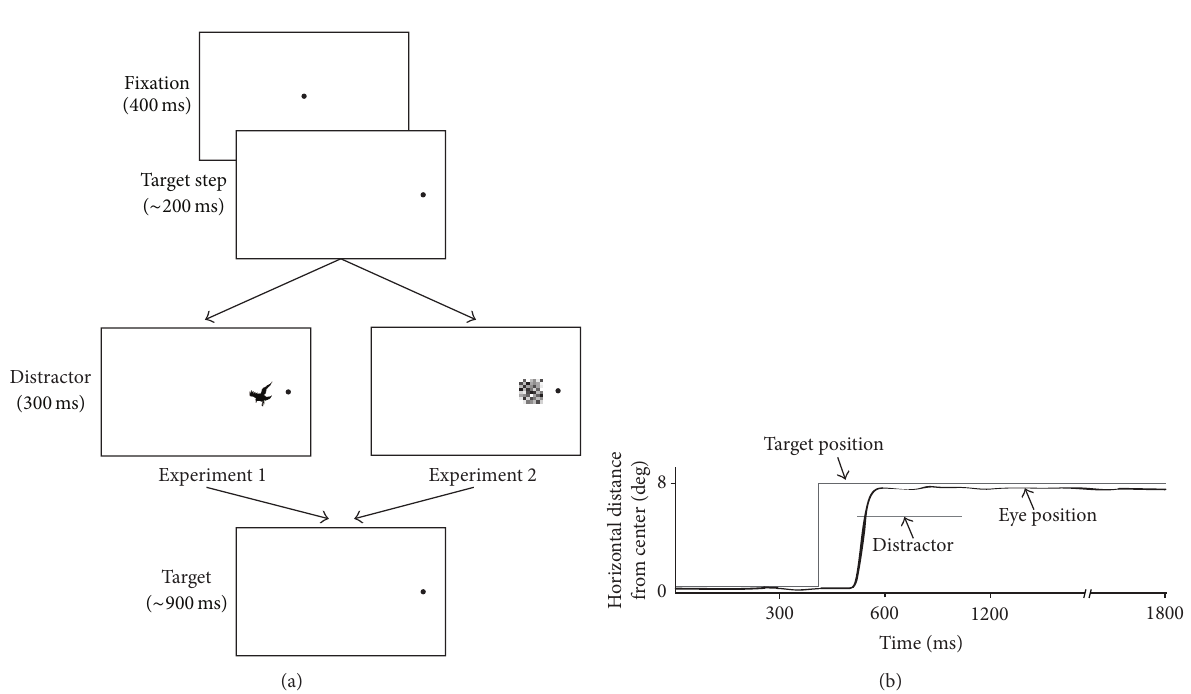
Figure 1: (a) Diagram of screen appearance and timing during the downward adaptation trials for the two experiments. Trials in both experiments consisted of a fixation, which stepped to the left or right after a brief variable delay (900–1400 ms, of which only 400 ms was recorded). Diagram shows a rightward step example only. Upon saccade detection, a visual distractor was presented for 300 ms, after which it disappeared leaving only the target on the screen in the stepped location. An example of both types of distractors used in both experiments is shown (drawn approximately to scale). See text for a description of the full set of distractors used in each experiment. (b) A schematic of target, distractor, and eye position during an adaptation trial. After the target step, the eye follows with a saccade, upon which time a distractor is presented a short distance from the target, which remains at the stepped location for the remainder of the